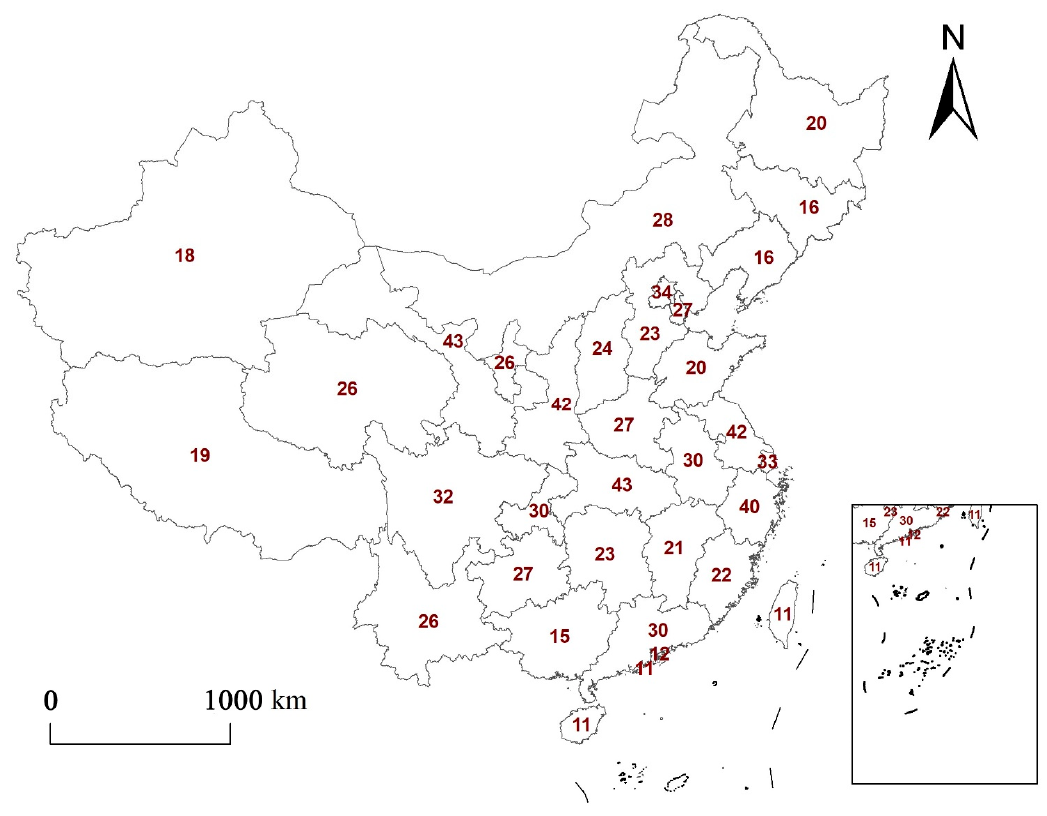
Figure 10. The distribution of the number of international trade-off studies. The numbers in the figure are the number of trade-off studies in each region.